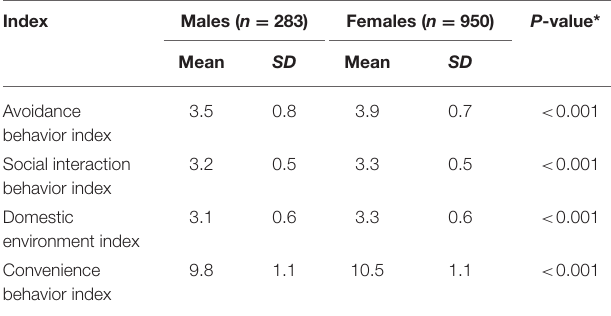
TABLE 3 | Mean scores of convenience-related behavior indices in males and females ( n =